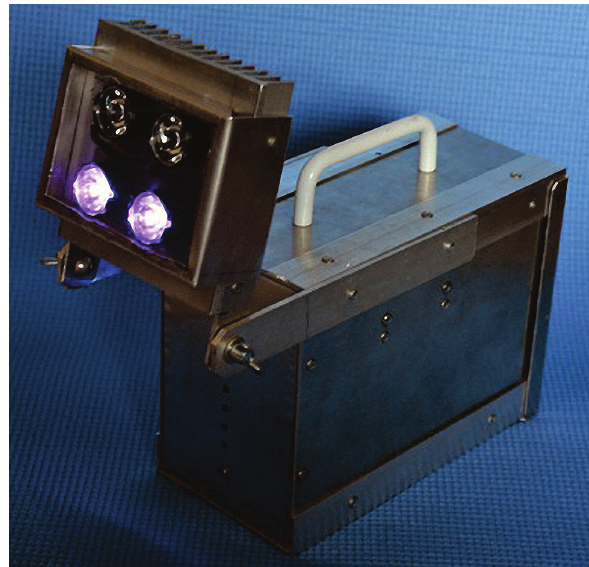
Figure 1. View of the device with the movable head upright and UV LEDs on. Scale: 10